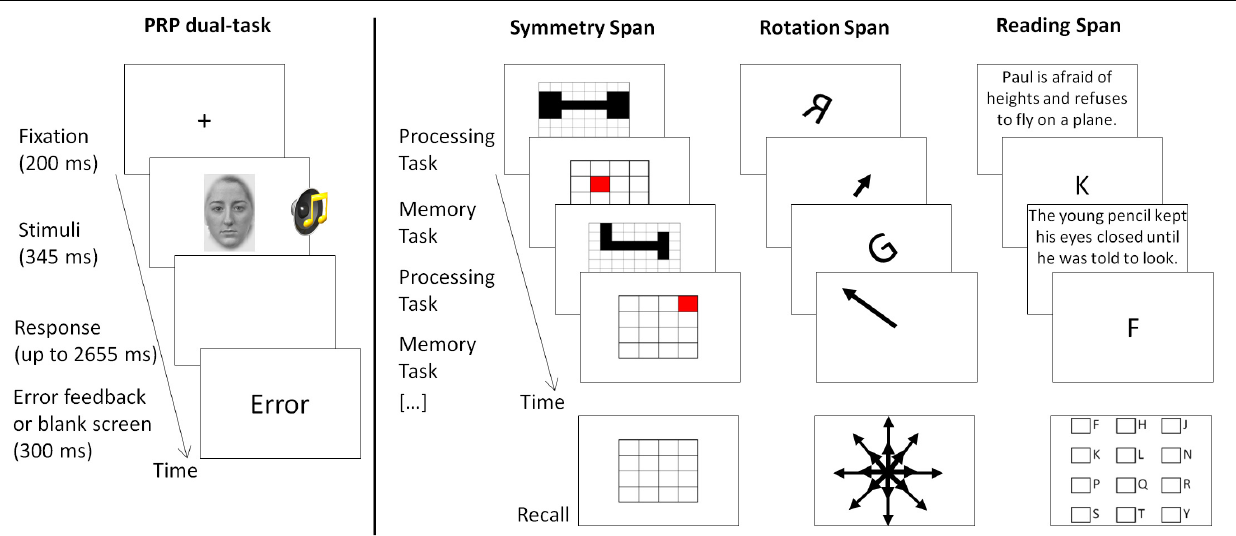
FIGURE 1 | Illustration of the trial design of the PRP dual-task (studies 1 and 2) and the three complex working memory span tasks (study 2). In the PRP dual-task participants responded using both hands on a computer keyboard. As soon as the number of required responses was given, the response registration period was terminated. In some studies, the numbers “1” or “2” instead of male or female faces were used as visual stimuli. In the span tasks (Foster et al., 2015), responses were given using a computer mouse. In the processing task, each screen showing the task (depicted above) was followed by another screen registering the answer (not shown above, presenting a question such as “Are these shapes symmetrical?” with two answer boxes, “Yes” or “No,” to be clicked with the